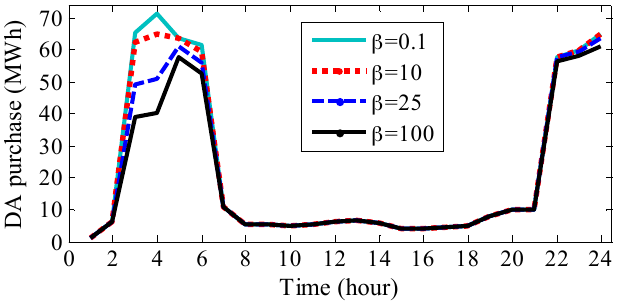
Figure 10. Expected DA procurement for different levels of β .